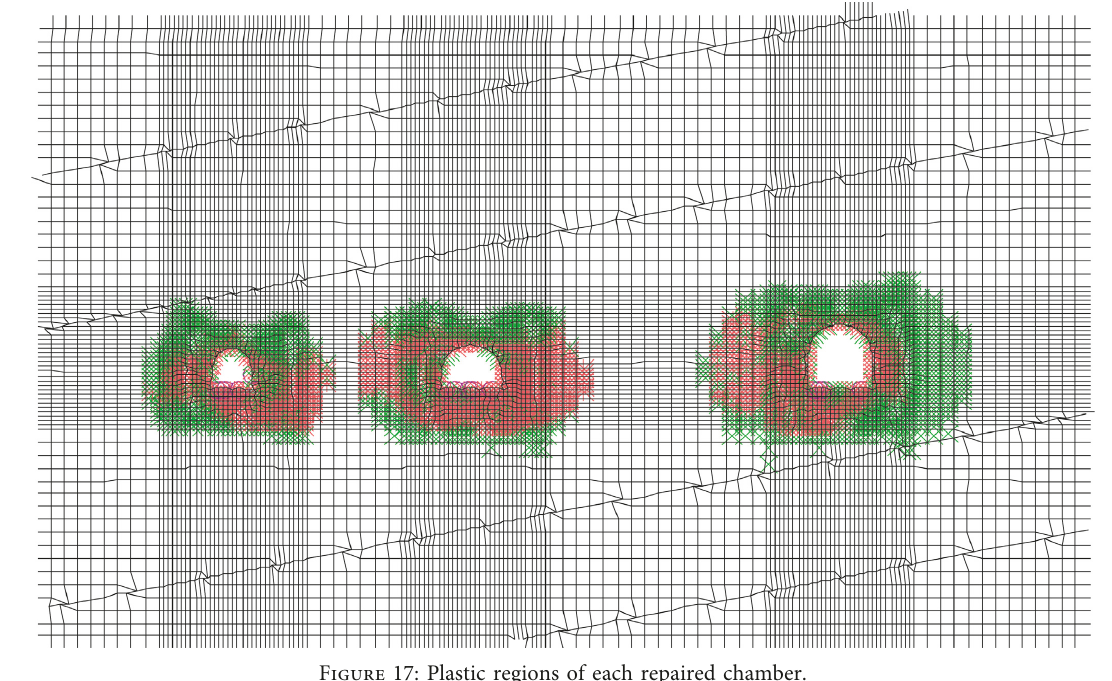
Figure 17: Plastic regions of each repaired chamber.